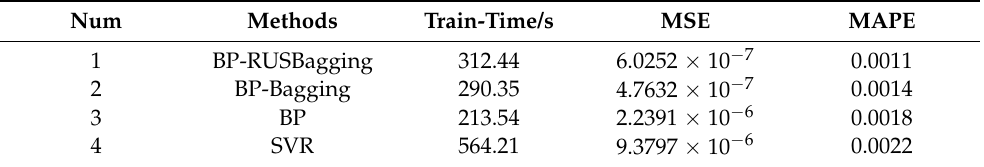
Table 2. Comparison of the performance of different methods on the whole test set.